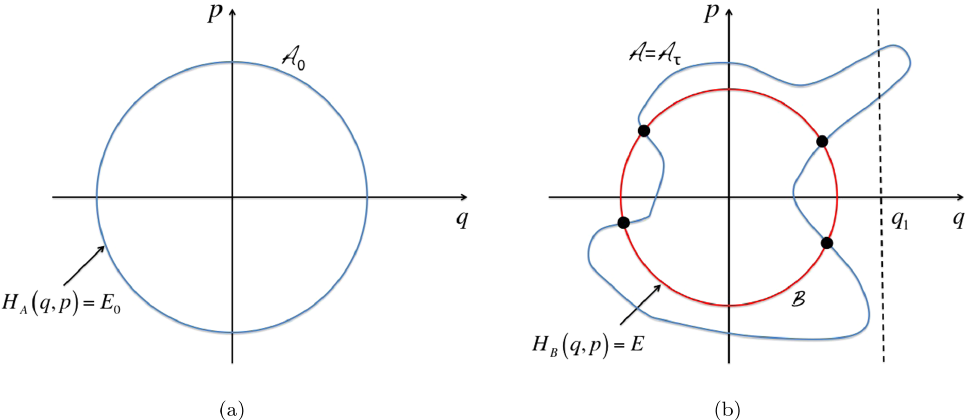
FIG. 1. An energy shell A 0 of the initial Hamiltonian [panel (a), t ¼ 0] evolves under H ð t Þ to the curve A ≡ A τ [panel (b), t ¼ τ ]. The curve B is an energy shell of the final